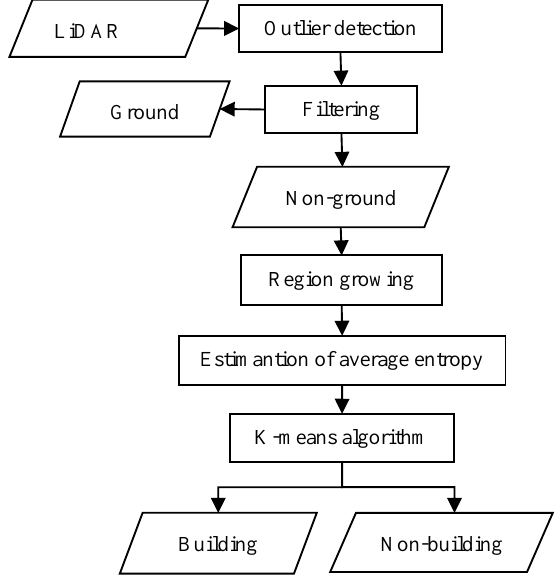
Figure 1. Flowchart of proposed